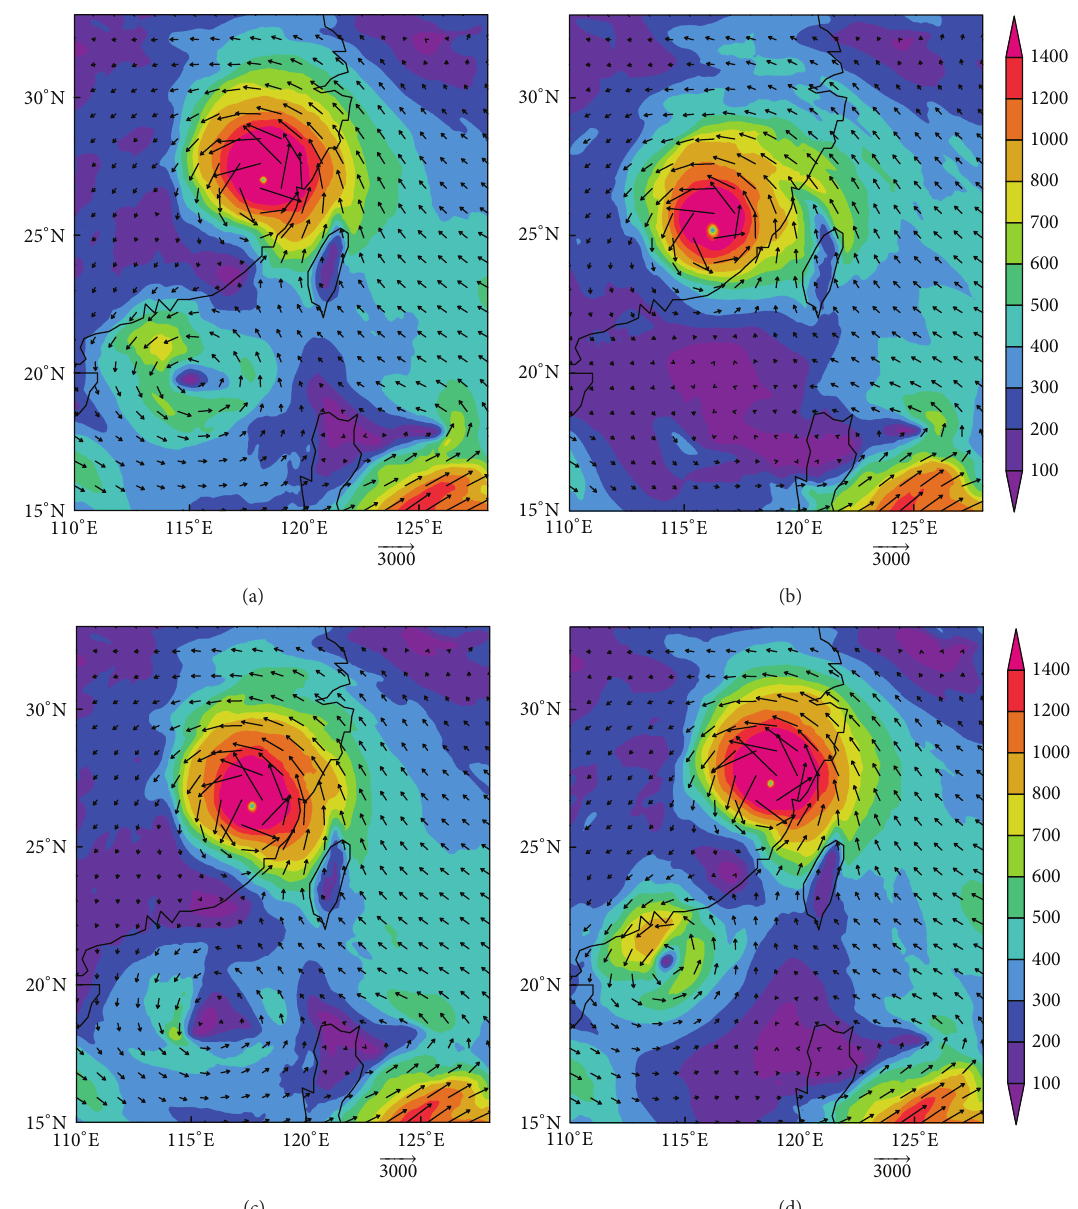
Figure 10: The same as Figure 9 except at 0000 UTC 11 August,